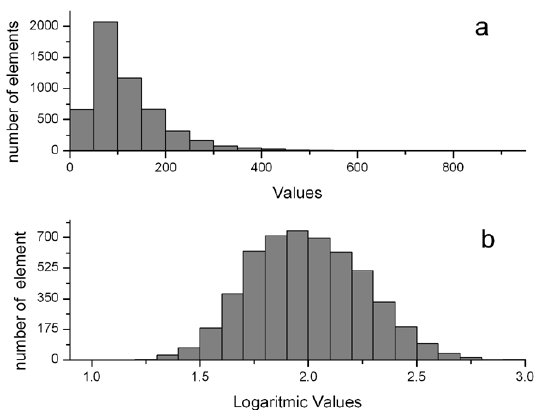
Figure 2. Frequency distribution histograms of the daily mean value of NO x at the Como site from 1992 to 2007. Raw data ( a ); and logarithmic data ( b ).